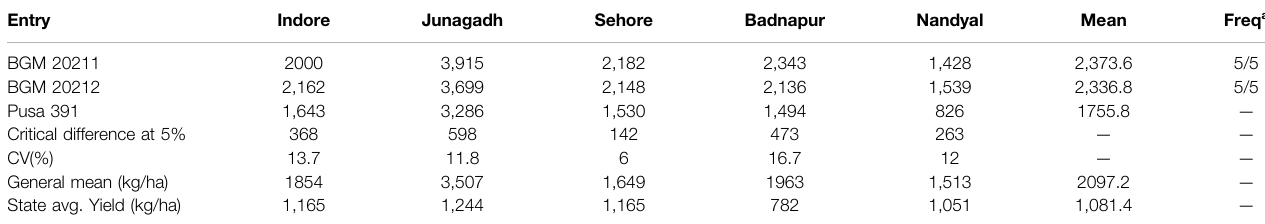
TABLE 5 | AVT-2 Comparison ofyield(kg ha − 1) performance ofBGM20211 and BGM20212 introgressionlinedeveloped inthe genetic background ofPusa391, withthe recurrent genotype at six locations in the Advanced Varietal Trials − 2 of ICAR – All India Coordinated Research Project on Chickpea conducted during 2019 – 2020